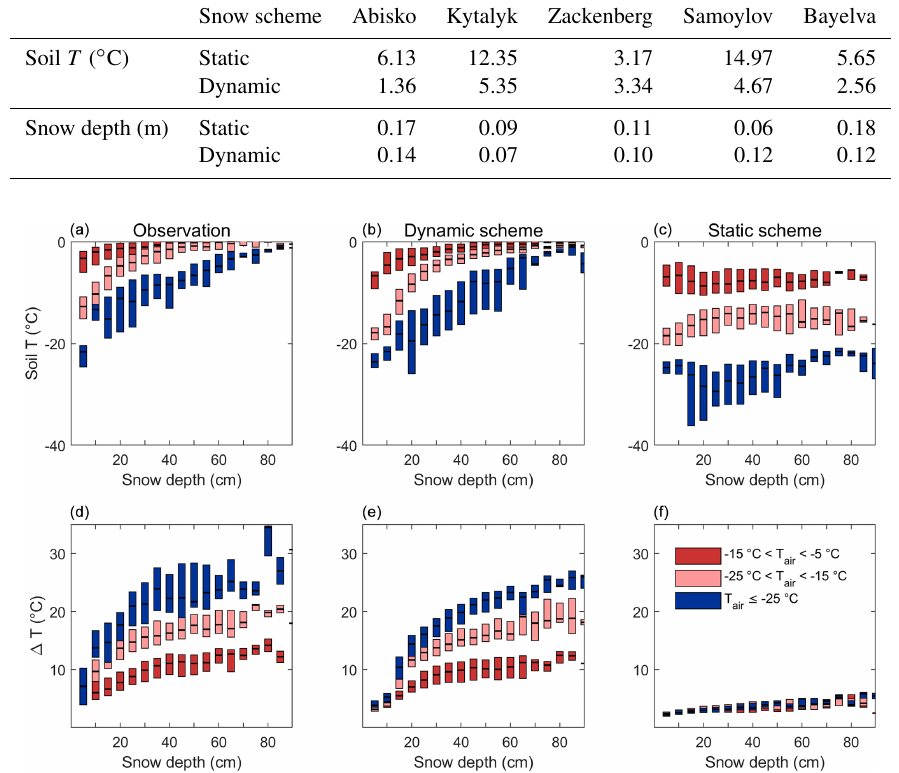
Figure 5. Comparison of the observed and modelled snow insulation effect at the Russian sites between observations and model simulations using the Dynamic and Static schemes. (a–c) Soil temperature and snow depth relationship. (d–f) Difference in air–soil temperature and snow depth relationship. Snow depth presented on the horizontal axis is classified in 5cm depth bins. Colours indicate different air temperature regimes, and upper and lower bars show the 25th and 75th